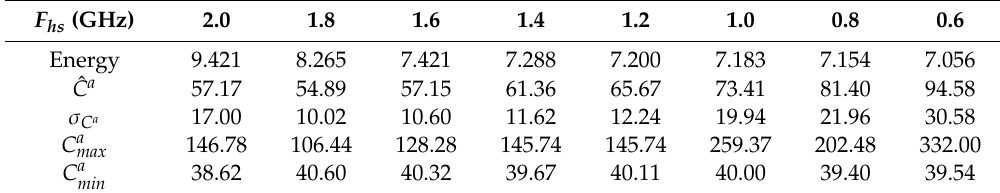
Table 14. Interactive governor with configuration 2 and di ff erent F hs values. Vid3.